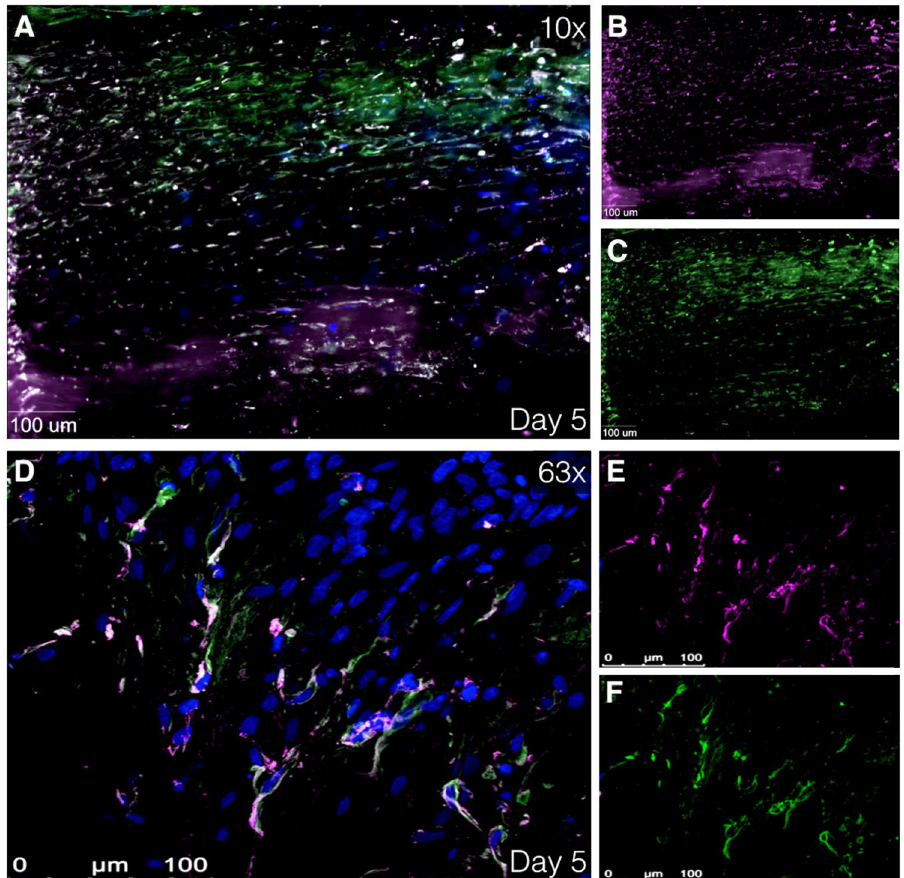
Figure 4. Immunofluorescence images showing smooth muscle cells. ( A – C ) Immunofluorescence images at 40 × magnification using using Zeiss Axiovert 200 M Marianas ™ Microscope at day 5 after harvesting. ( D – F) Immunofluorescence image at 63 × magnification using super resolution Confocal Laser Scanning Microscope Leica TCS SP8. Human tissue stained with α -SMA and smoothelin (smooth muscle cell markers) at day 5 after harvesting. ( A , D) Merged image of α -SMA (purple), smoothelin (green) and DAPI (blue). ( B , E) Isolated α -SMA staining. ( C , F) Isolated smoothelin staining. α -SMA indicates alpha smooth muscle actin and DAPI, 4 ′